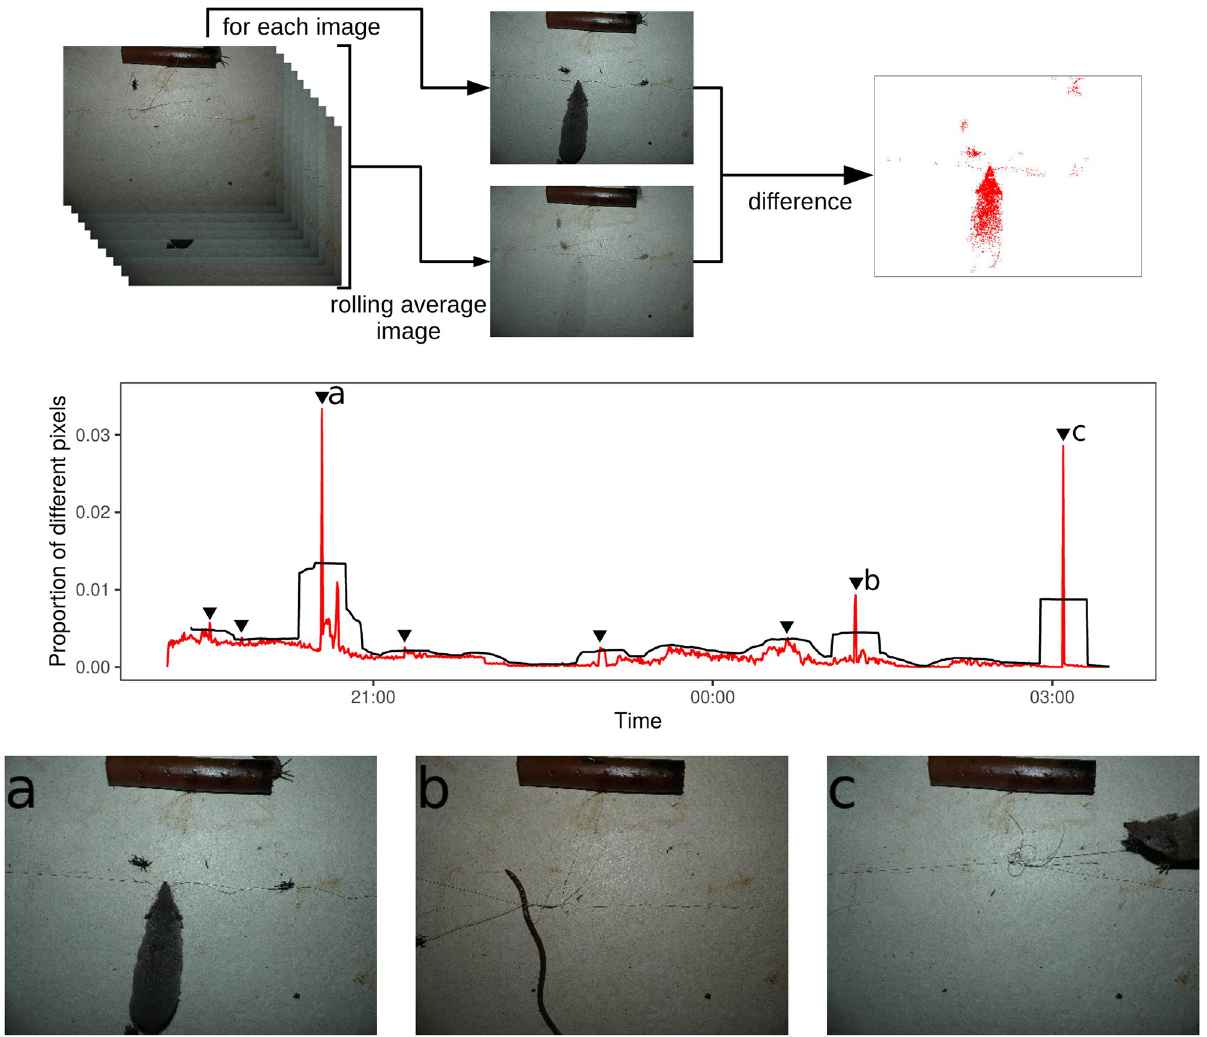
Fig 2. Example of predator detection with a 1000-image sequence in our dataset. The black line represents the μ + 2 σ threshold for the selection of images. When the proportion of different pixels (red line) exceeds this threshold, images are selected for review (pointers on the graph). Here, 8 of 1000 images are selected, including two that showed predation of C . sordidus ( a and c ). Other large changes in the image content correspond to detection of other animals, such as an earthworm ( b